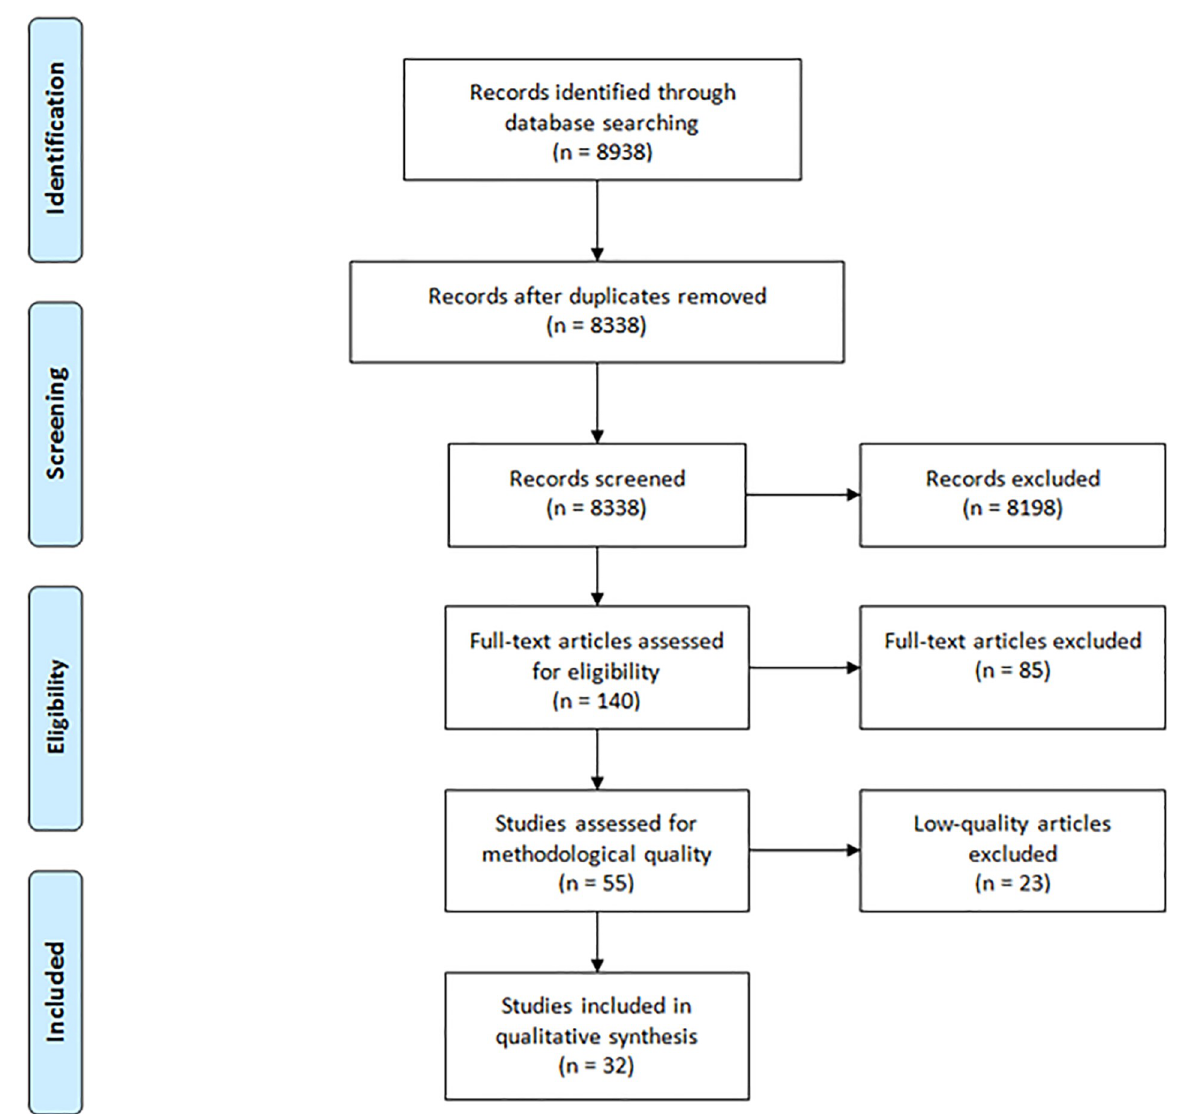
Fig 1. PRISMA flow diagram for original search up to 18 th January